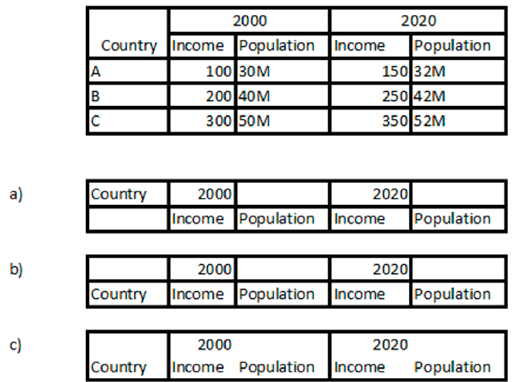
Figure 1. Possible misinterpretations of complex table.